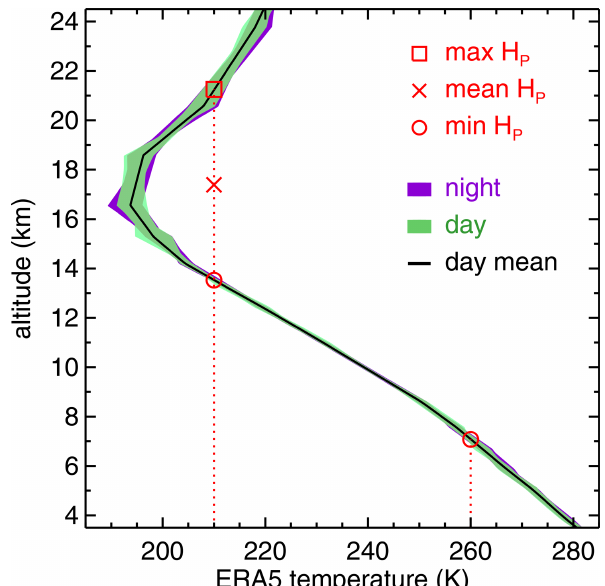
Figure 4. The envelope of nighttime (magenta shading) and day- time (green shading) ERA5 temperature profiles and the daytime- mean temperature profile (black line) for La Soufrière over the main eruptive period of 9–14 April 2021. As a demonstration of the tem- perature method, the plume heights H P corresponding to a dark pixel temperature of 210K (two solutions) and 260K (single so- lution) are also